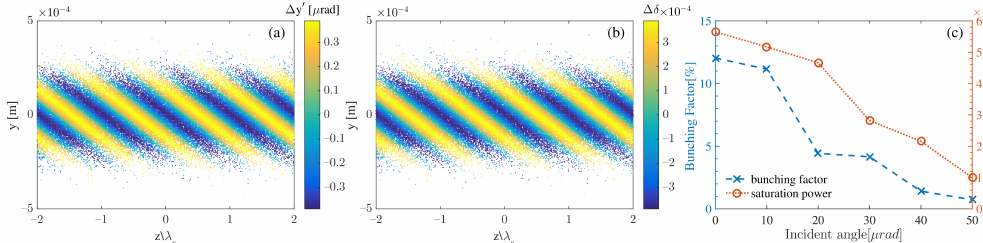
Figure 4. The effect of obliquely incident laser. ( a , b ) Distributions of the transverse divergences and energy deviations after the obliquely incident laser-electron interaction. The incident angle of the seed laser is 1mrad in the z − y plane; and, ( c ) the influence of seed laser incident angle on the bunching factor (blue) and saturation power